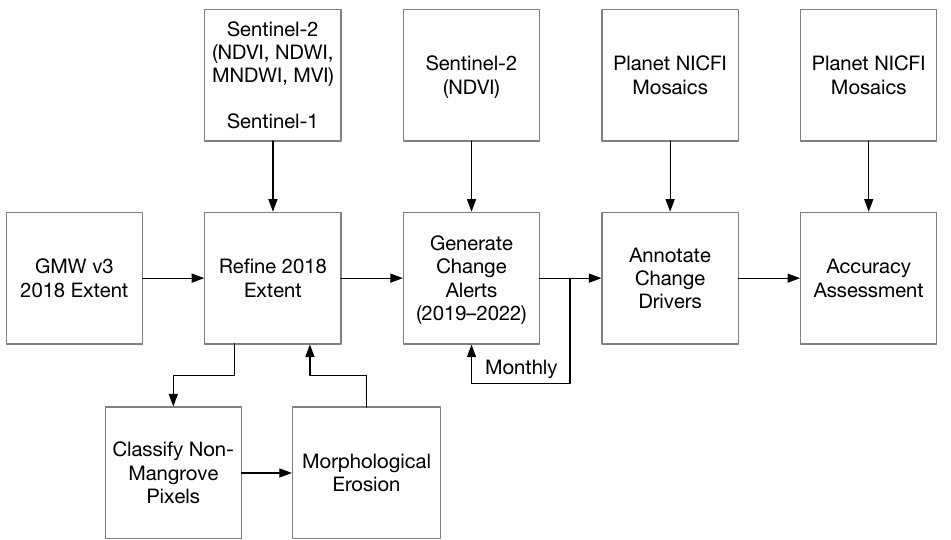
Figure 2. Flowchart illustrating the steps involved in the analysis. Acronym definitions: Global Man- grove Watch (GMW), Norway’s International Climate and Forests Initiative Satellite Data Program (NICFI), normalised difference vegetation index (NDVI), normalised difference water index (NDWI), modified normalised difference water index (MNDWI), mangrove vegetation index